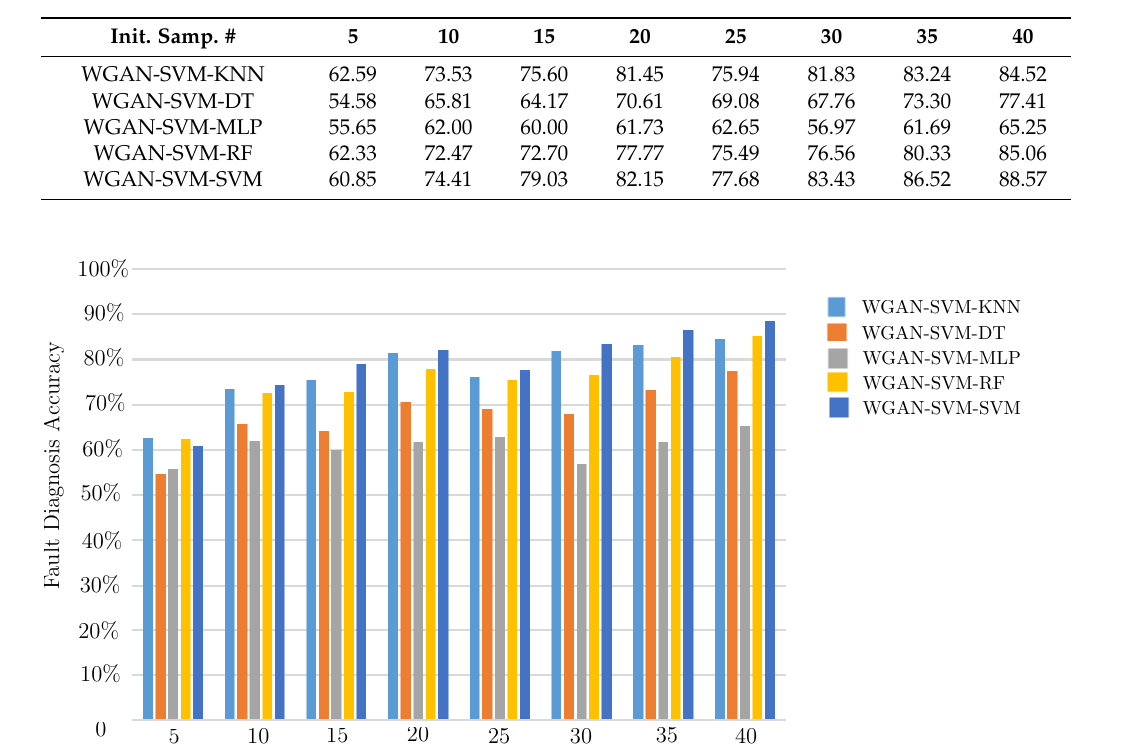
Figure 5. Classification/diagnosis results comparison between various classifiers using WGAN-SVM to generate artificial faulty training